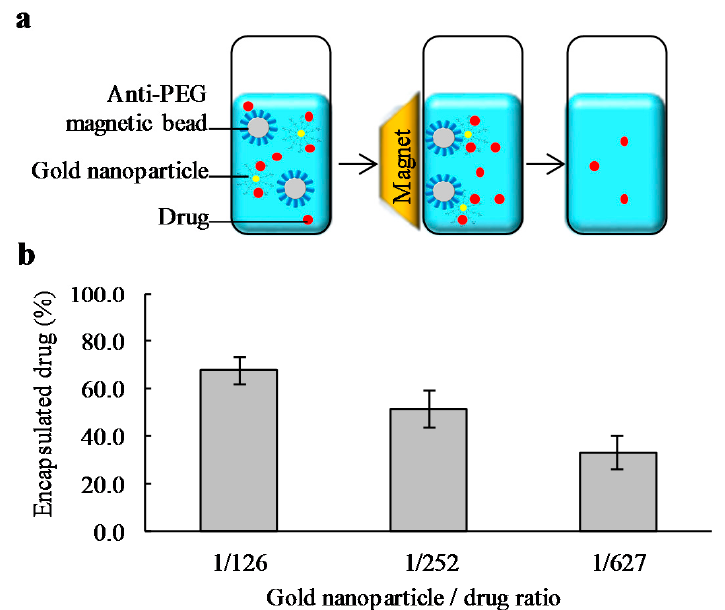
Figure 2. ( a ) Protocol for the separation of encapsulated drugs from free drugs that uses anti-PEG magnetic beads. ( b ) Relative levels of drug (bimatoprost) encapsulated by GNP 2000 when GNP/drug ratios of 1/126, 1/252 and 1/627 are used.